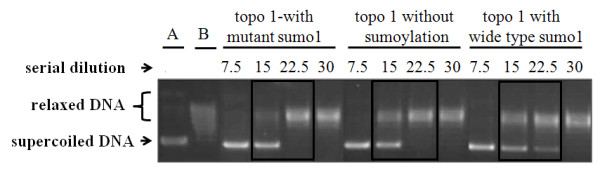
Measurement of catalytic function of recombinant human topo I with and without sumoylation reaction. Recombinant human topo I proteins were sumoylated with either mutant sumo1 or wild type sumo1 or negative control (without sumoylation), and then were examined for their catalytic function in a serial dilution. Sumoylation of topo I with wild type sumo1 showed a reduction of efficiency in catalytic function (supercoiled DNA disappeared at the dilution of topo I concentration of 30) compared to the topo I protein sumoylated with mutant sumo1 or negative control (supercoiled DNA disappeared at topo I concentration of 22.5). This is representative of three assays. *A, standard supercoiled DNA band; B, standard relaxed DNA bands.